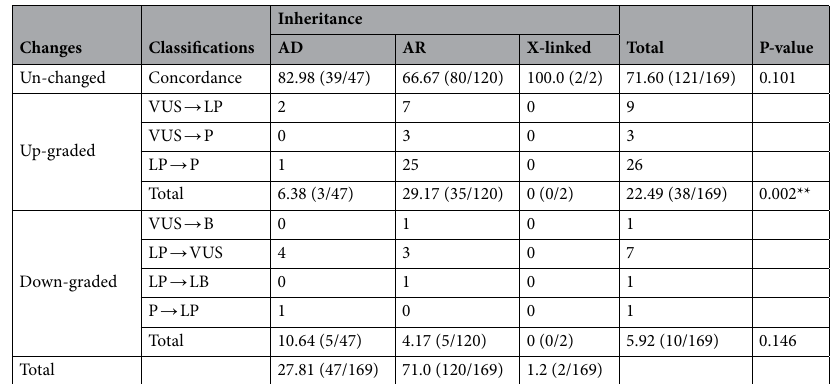
Table 2. Changes of variant classifications according to inheritance patterns. P pathogenic, LP likely pathogenic, VUS variant of uncertain significance, LB likely benign, B benign. *P < 0.05, Chi-square test,